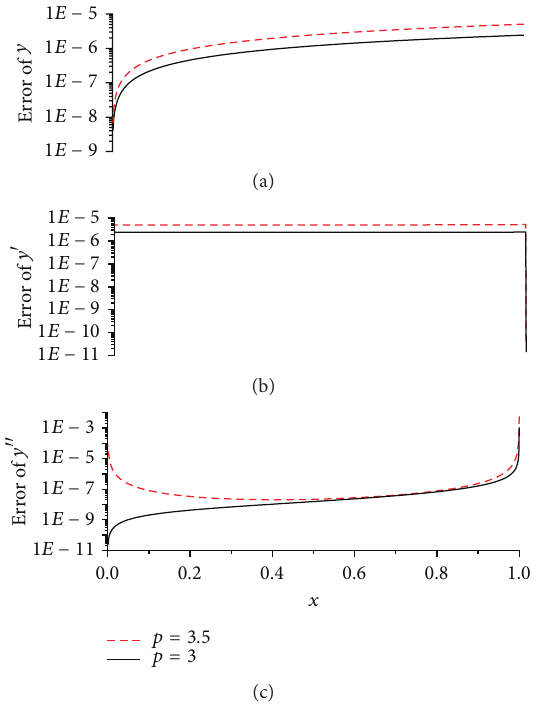
Figure 2: Example 1 with 𝑝 = 3 and 𝑝 = 3.5 , showing the numerical errors of (a) 𝑦 , (b) 𝑦 󸀠 , and (c) 𝑦 󸀠󸀠 .